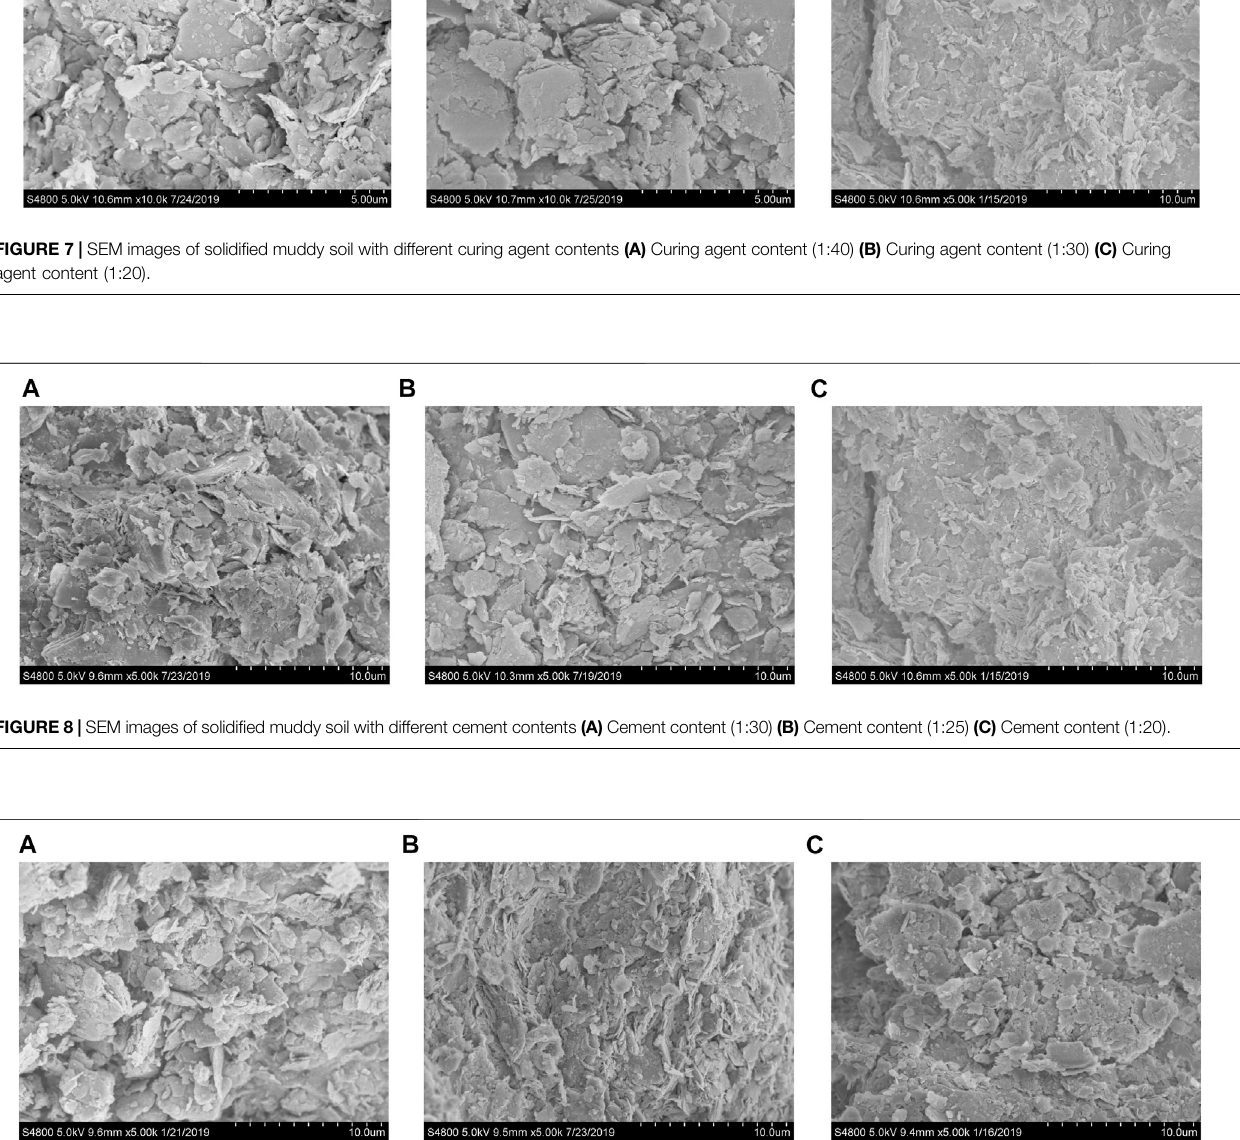
Frontiers in Materials |